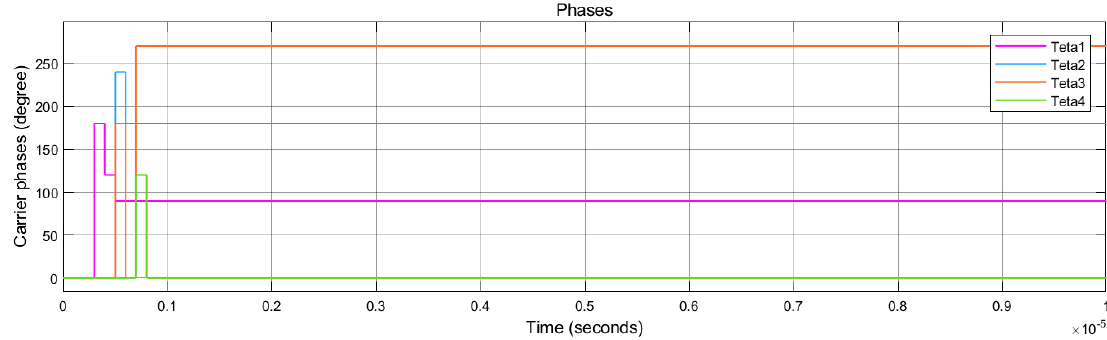
Figure 12. Simulation result of four interleaved carriers using DSA-PSC method.